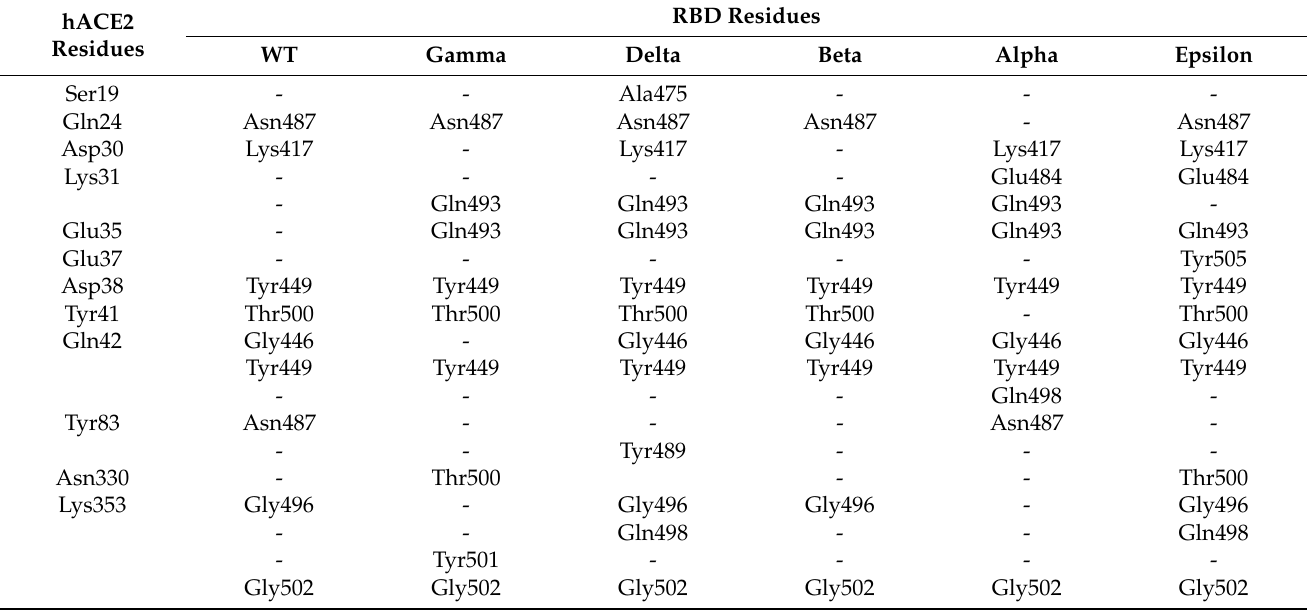
Figure 3. Protein–protein docking representation of hACE2 and RBD WT complexes. ( A ) The complexes binding interface; ( B ) The amino acids binding interaction; and ( C ) The interaction representation, which includes hydrogen ( ), salt bridges ( ), and non-bonded ( ) interactions. Chain A represents hACE2 and chain B represents RBD WT. Residue colors: positive (blue): H,K,R; negative (red): D,E; neutral (green): S,T,N,Q; aliphatic (grey): A,V,L,I,M; aromatic (purple): F,Y,W; Pro & Gly (orange): P,G. Table 2. The H-bonds between hACE2 and the active site of